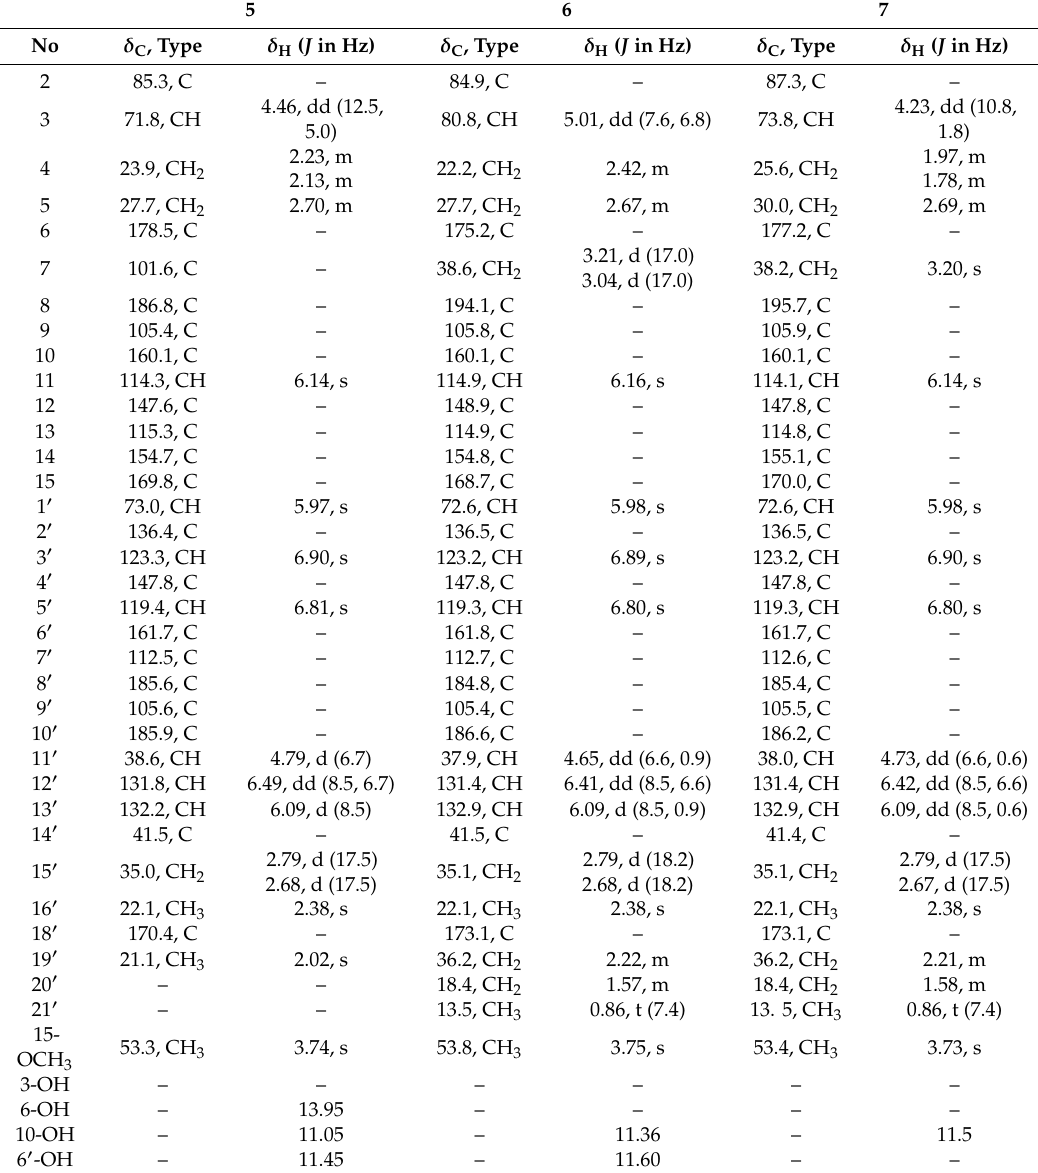
Table 2. 1D-NMR spectroscopic data for compounds 5 – 7 (in CDCl 3